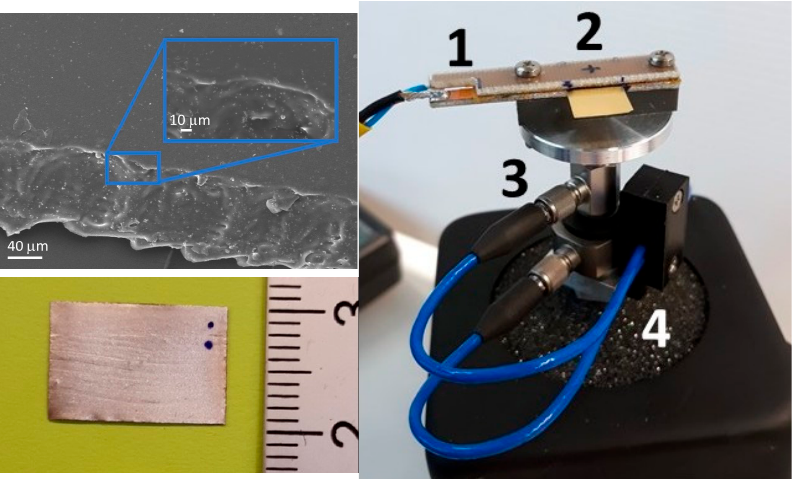
Figure 2. ( Left , up ) SEM micrograph of a typical laser-cut EB/ZFL film sample. ( Left , down ) Sample of EB/ZFL after the silver painting with a brush. The rectangular part on the left is clamped into the sample holder. ( Right ) View of the system used to clamp the sample under test (1,2) and the two sensors